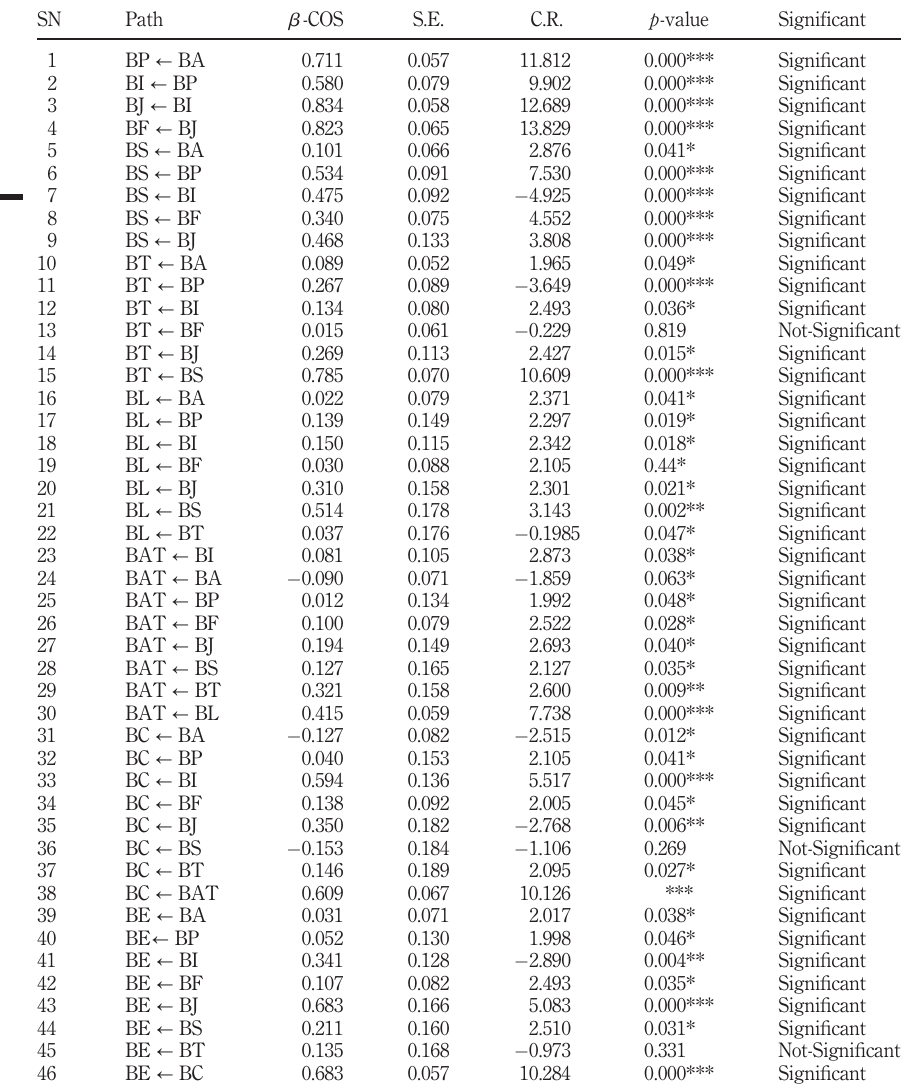
Table III. Mediation model